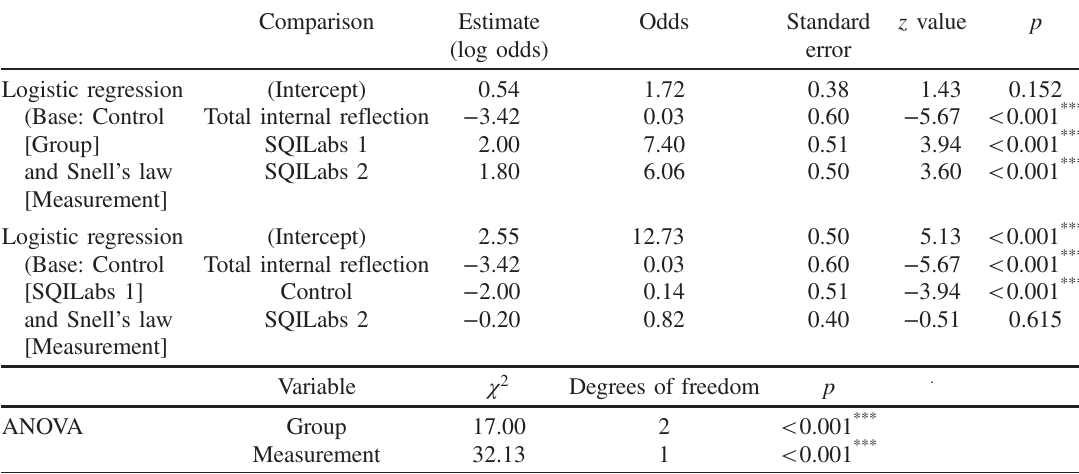
TABLE VII. Logistic regression and ANOVA table for whether students made changes to their measurements, examining only students with initially inaccurate measurements and those who did make comparisons. Base comparison is the control group (for year) and Snell ’ s law (for measurement). * p < 0 . 05 , ** p < 0 . 01 , *** p < 0 . 001